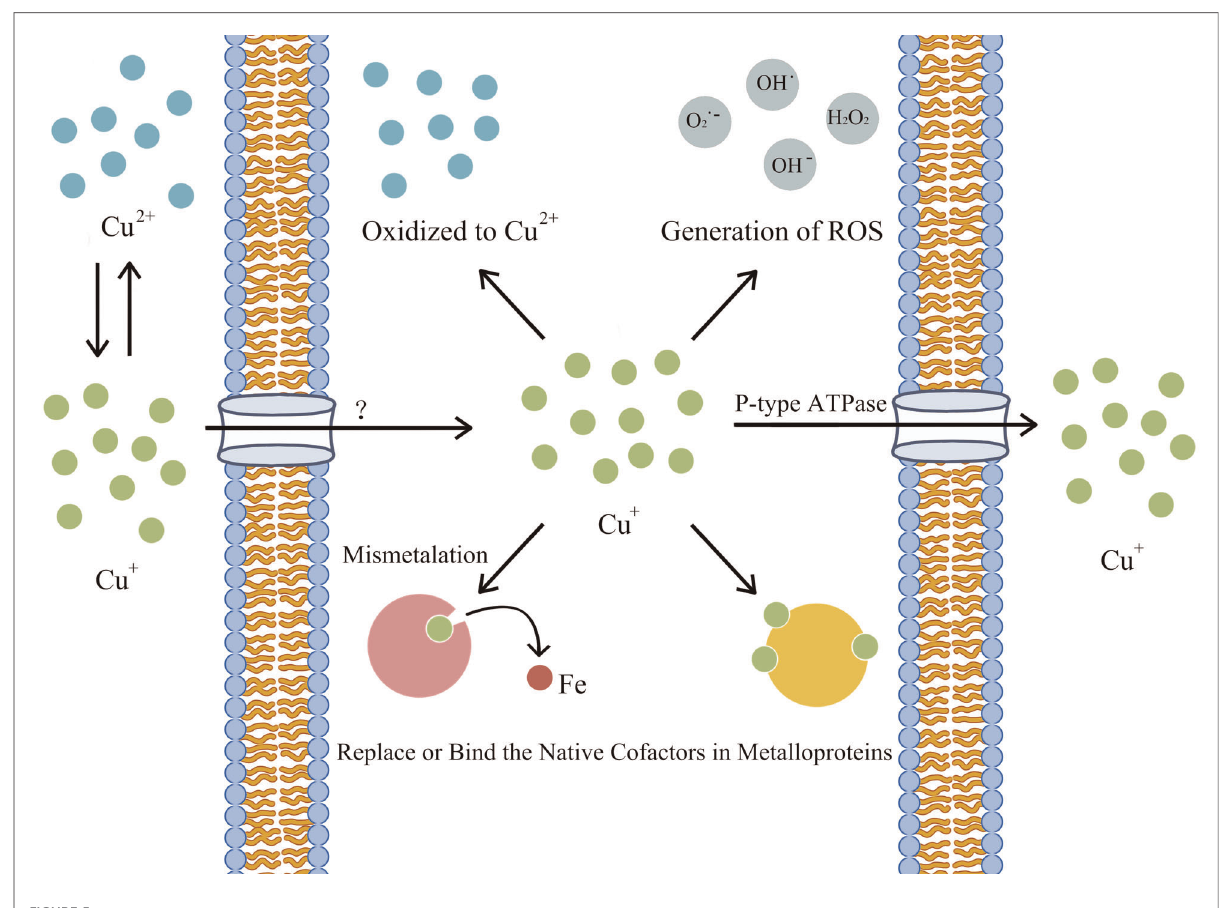
FIGURE 5 Copper transport system in